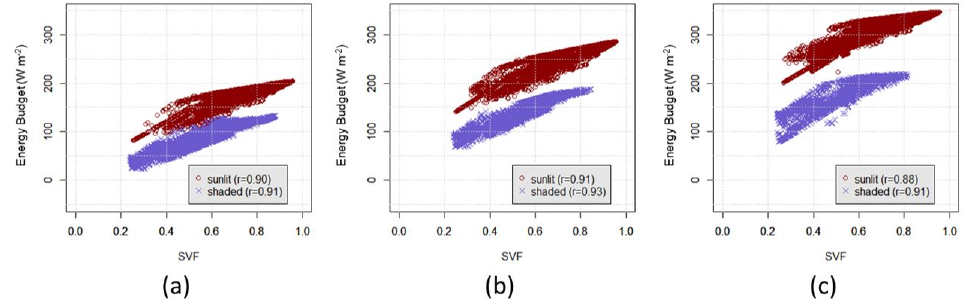
Figure 5. EB variations across time and space as a function of SVF and shade on August 9, 2016 at ( a ) 7 a.m.; ( b ) 9 a.m.; and ( c ) 1 p.m.